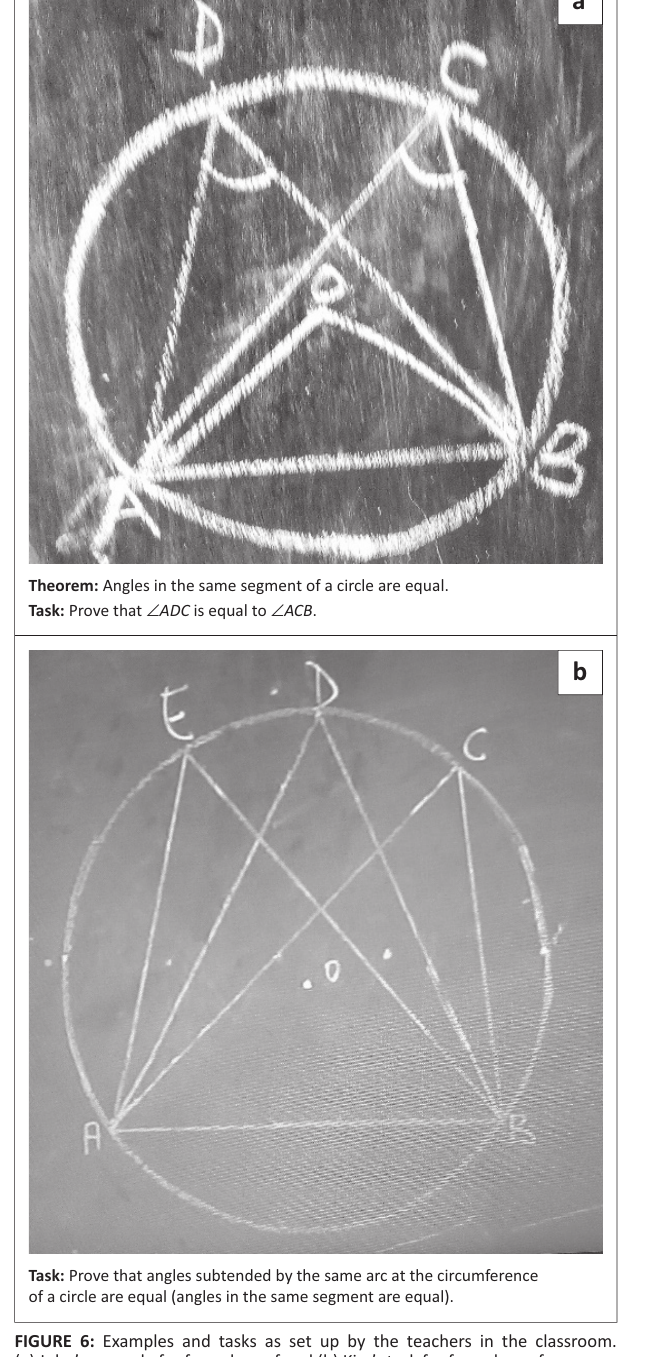
FIGURE 6: Examples and tasks as set up by the teachers in the classroom. (a) John’s example for formal proof and (b) Kim’s task for formal proof.